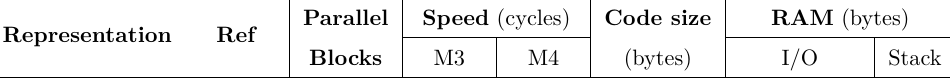
Table 5: Implementation results on ARM Cortex-M3 and M4 for fully-fixsliced implemen- tations of the Skinny-128 family of tweakable block ciphers. Speed is expressed in cycles per block and the RAM requirements for the round keys are enclosed in